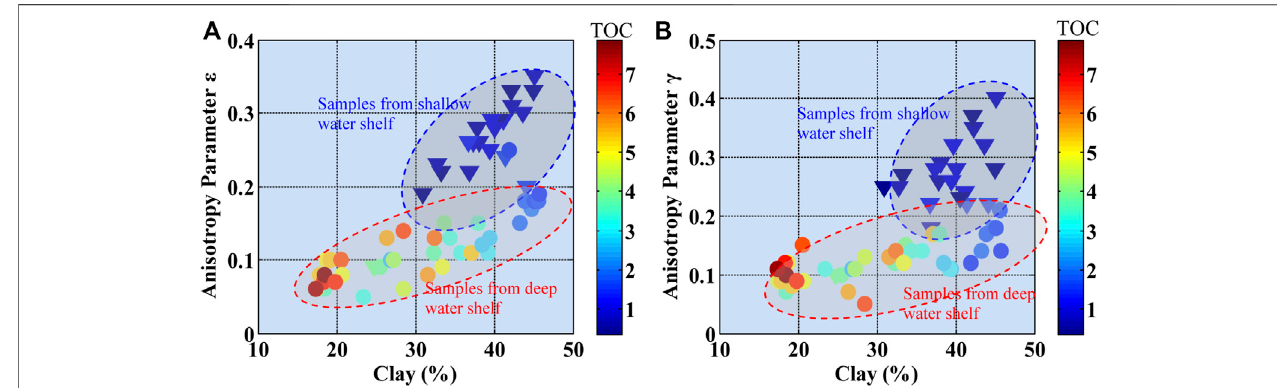
FIGURE 8 | Anisotropy parameters ε (A) and c (B) as function of clay content of shale samples. Data points are sorted by clay content and sedimentary circumstance and TOC content (color bar).